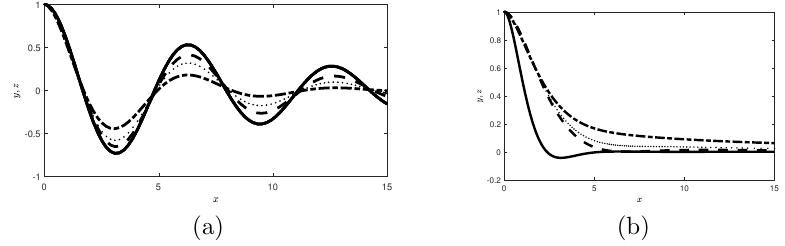
Figure 3. The solutions to damped harmonic oscillator (solid black line) and fractional damped harmonic oscillator (dashed, dotted and dash-dotted lines represent n = 20 , 10 , 5 respectively) for λ = − 0 . 1 ,µ = 1 ,A = 1 ,B = 0 in (a) and λ = − 1 ,µ = 1 ,A = 1 ,B = 0 in (b). The derivative order m is set to 2 n − 1 in all cases. It can be seen that as m becomes n closer to 2, the solution of the fractional damped harmonic oscillator tends to the non-fractional solution (4.3). Also, for values of m significantly smaller than 2, the n damping effect is more powerful in the case λ = − 0 . 1 (see (a)). However, if λ = − 1, the opposite is true – the solutions decay more slowly when m differs most from 2 (see n